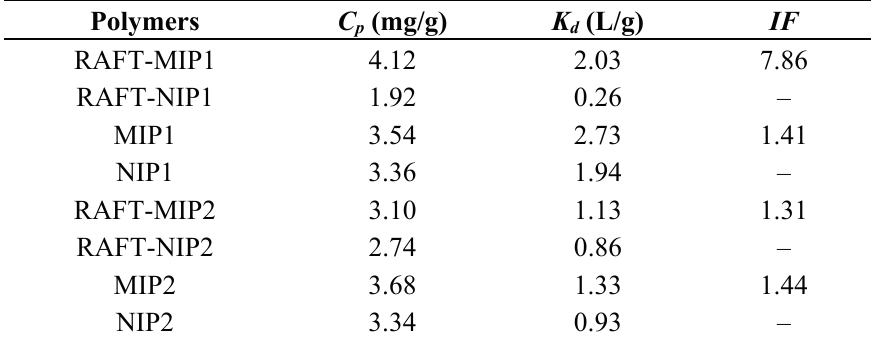
Table 2. Recognition of BzP on the polymers (MIPs dosage: 0.05 g; volume of BzP solution: 0.02 L; initial concentration of BzP: 10 mg/L).